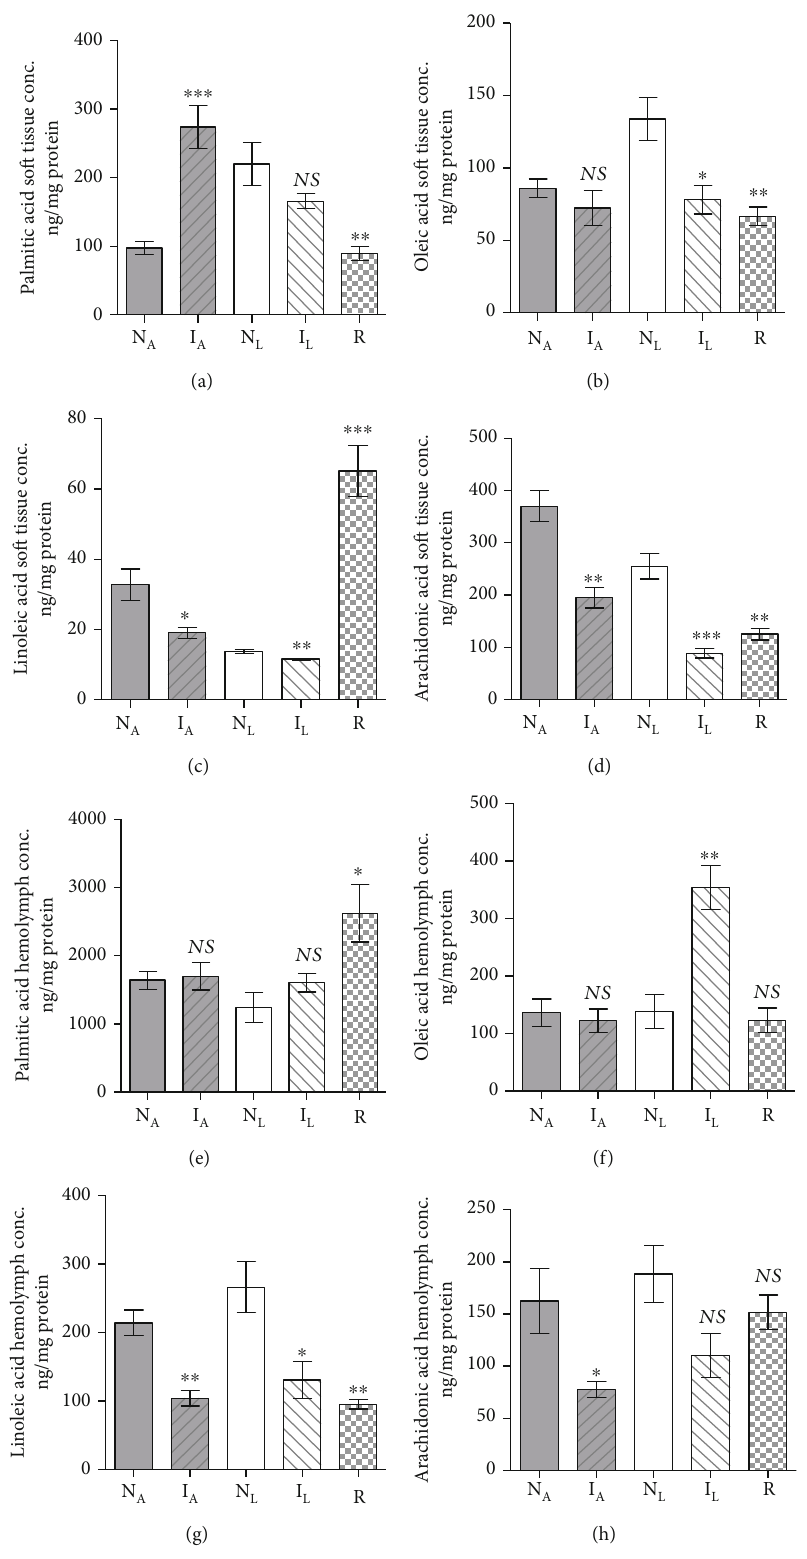
Figure 5: Each column represents mean soft tissue palmitic (a), oleic (b), linoleic (c), and arachidonic (d) acid and hemolymph palmitic (e), oleic (f), linoleic (g), and arachidonic (h) acid content for fi ve B. truncatus snails, and vertical bars the SE about the mean. N I : infected-algae fed; N : naïve-lettuce fed; I : infected-lettuce fed; R: resistant snails (lettuce fed). Statistical di ff erences between naïve and A L L infected or resistant same diet-fed snails are shown; ∗∗∗ P < 0 : 001 , ∗∗ 0 : 001 < P < 0 : 005 , ∗ P < 0 : 05 . NS: not signi fi